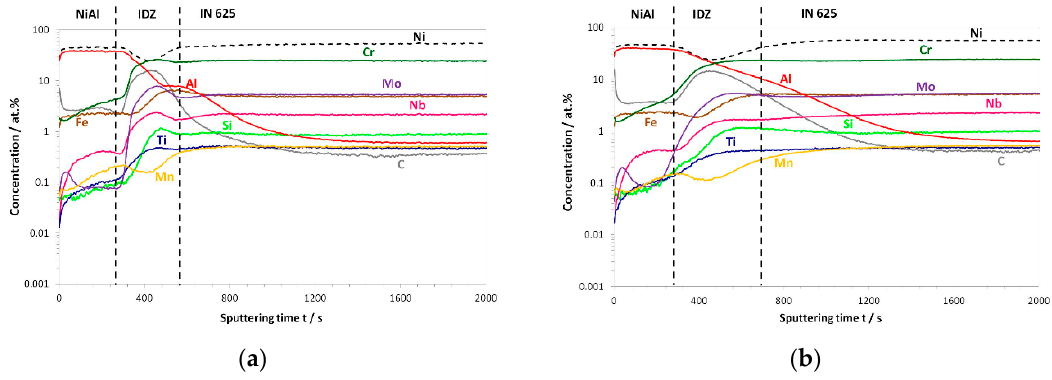
Figure 7. The glow discharge optical emission spectrometer (GD-OES) depth profiles obtained for the aluminide layer formed on: ( a ) Ground and ( b ) grit-blasted IN 625 in the as-received condition.